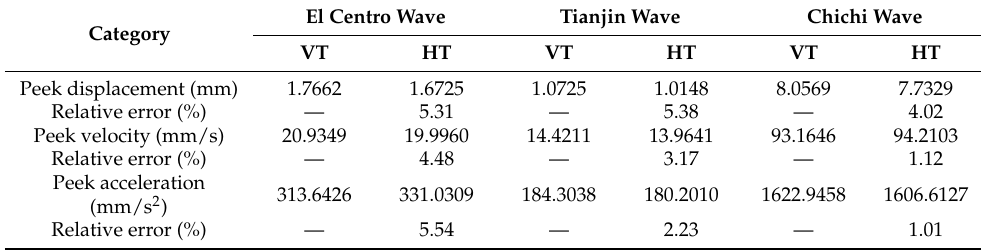
Table 3. Comparative analysis of Model B.